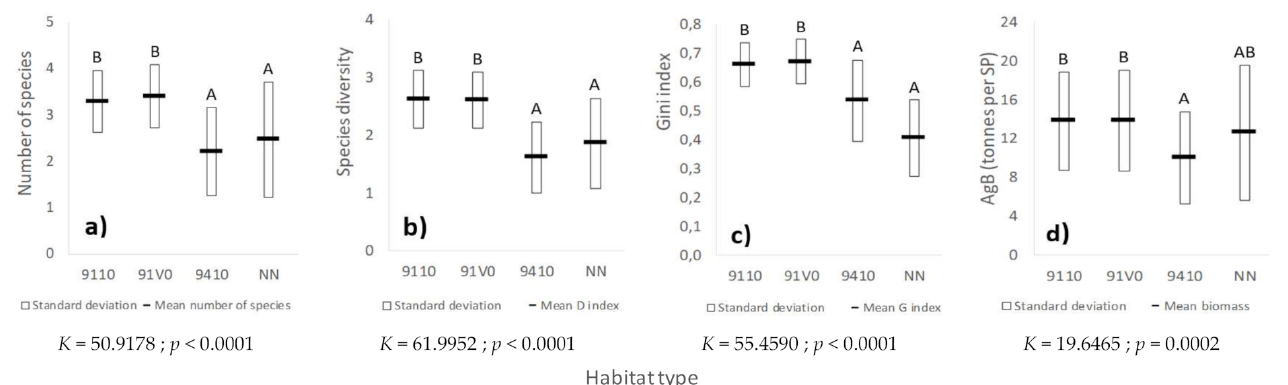
Figure 9. Comparative analysis of habitats by tree species richness ( a ) and diversity ( b ), tree size heterogeneity ( c ) and aboveground biomass ( d ). Different uppercase letters indicate significant differences between classes according to Conover– Iman Multiple pairwise comparisons procedure ( p < 0.05); K represents the Kruskal–Wallis constant, while p indicates the significance